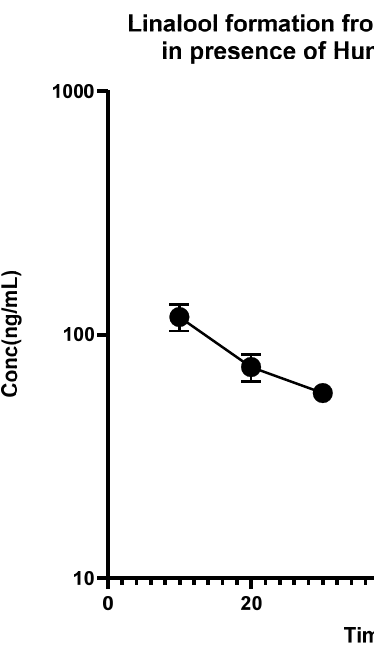
Figure 3. Time-dependent formation of linalool from linalyl acetate in human liver microsomes. Human liver microsomes were incubated with linalyl acetate (10 µM) for 0–120 min in the presence of cofactors. The data are expressed as mean ±SEM.